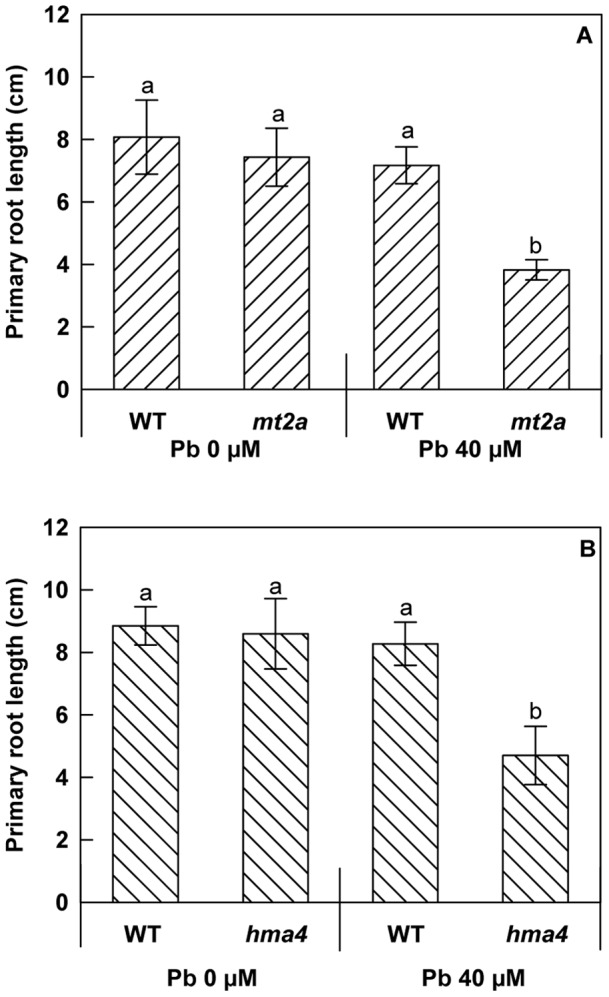
Effects of lead treatment on primary root length in wild-type and knockout mutant seedlings of A. thaliana.Seedlings were grown for 13 days on vertically orientated agar plates with or without 40 µM of Pb(NO3)2. (A) Atmt2a T-DNA mutant analysis. (B) Athma4 T-DNA mutant analysis. All results are the average value (± SE) of 16 seedlings. The letters represent statistically homogenous subgroups using LSD post hoc test at a α = 0.01 significance level.